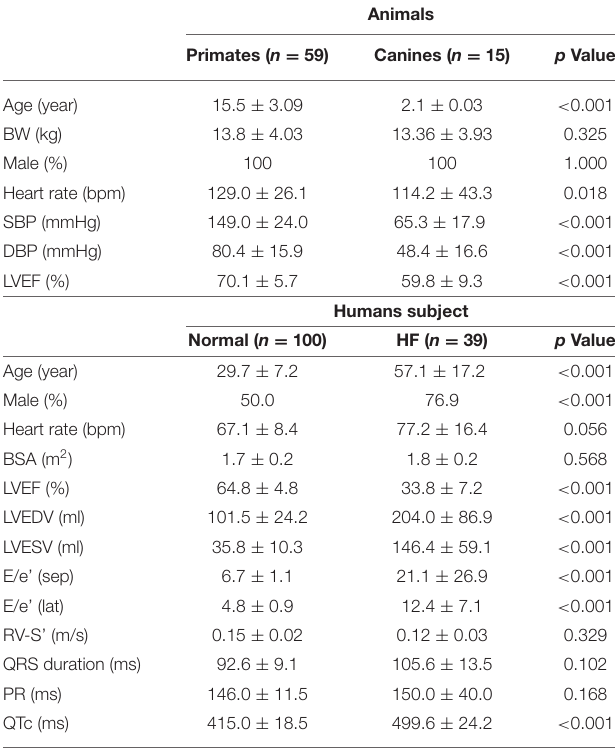
TABLE 1 | Baseline characteristic of the study subjects.